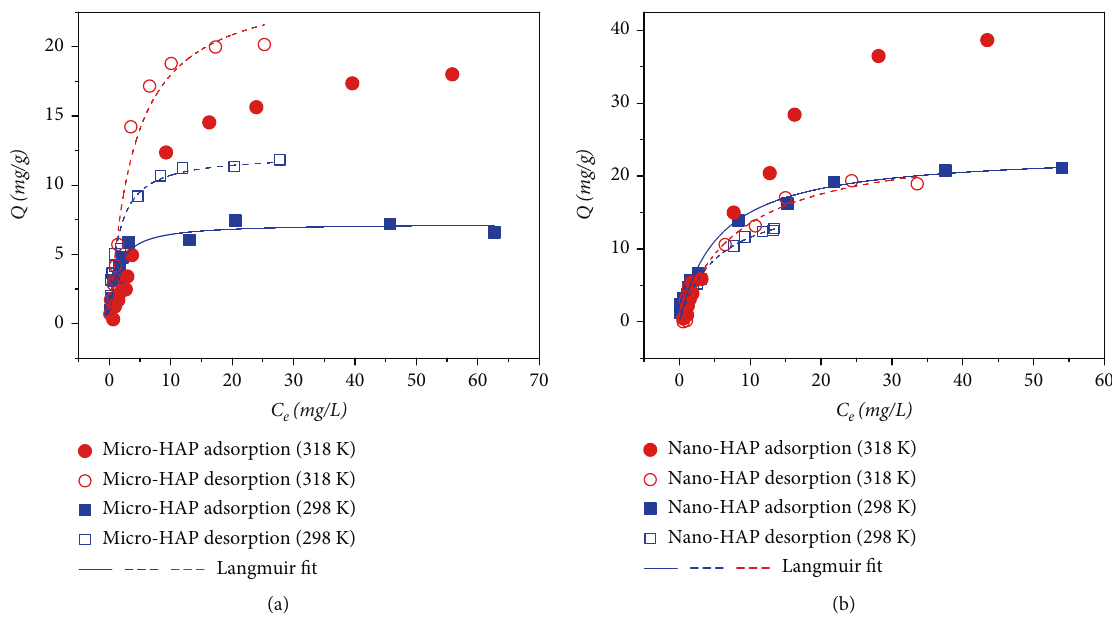
Figure 6: Adsorption/desorption isotherms at 298K and 318 K of Ni(II) adsorption on (a) micro-HAP and (b) nano-HAP ( I = 0 : 1 mol/L , s / l = 0 : 6 g/L, and pH = 6 : 7 ± 0 : 1 ). NaClO 4